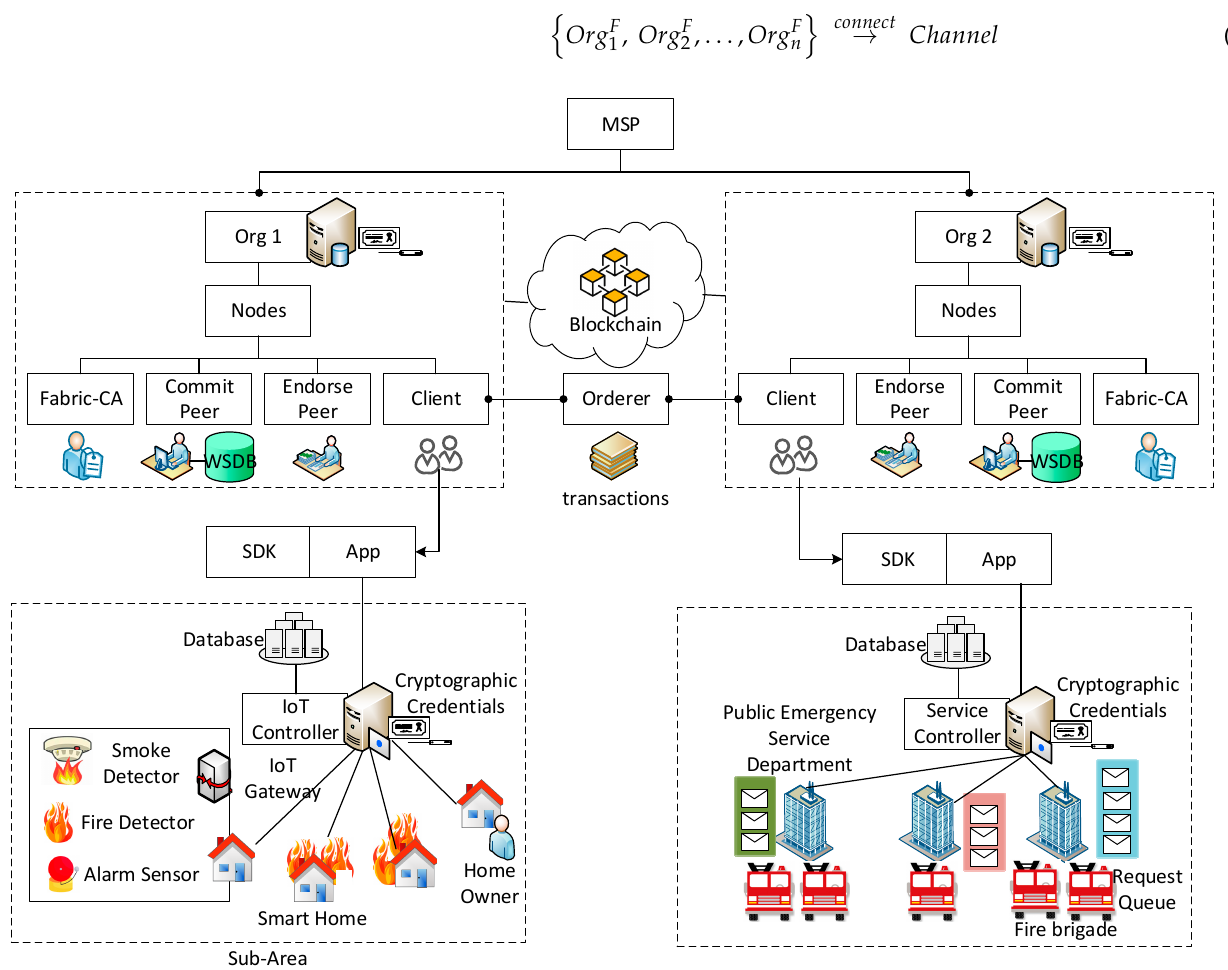
Figure 5. Functional architecture of the BEST framework.